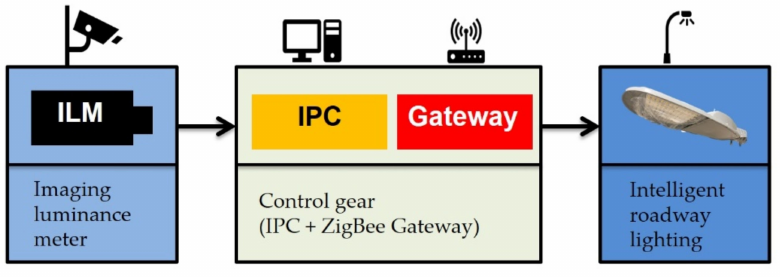
Figure 15. The structure of the human-centric roadway lighting system.